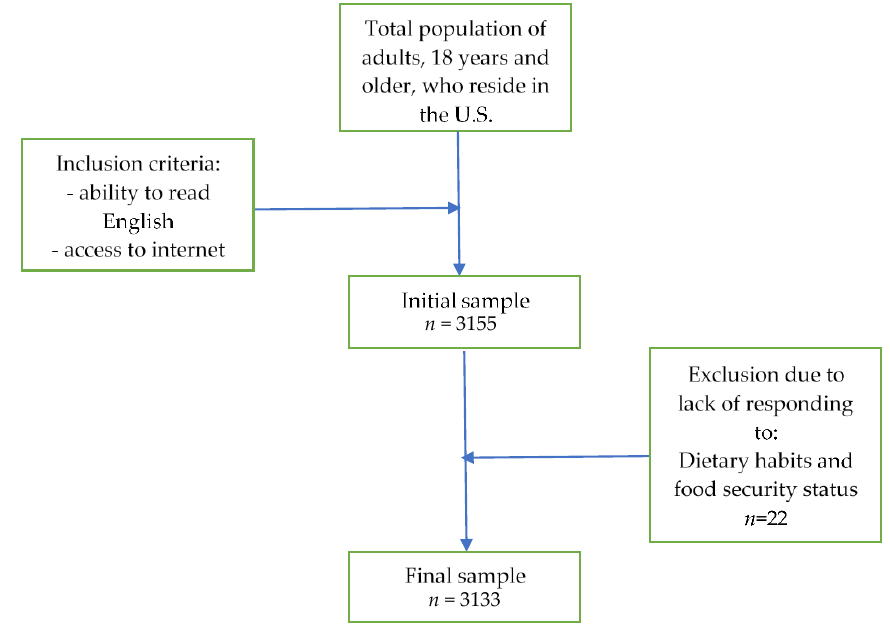
Figure 1. Sample collection